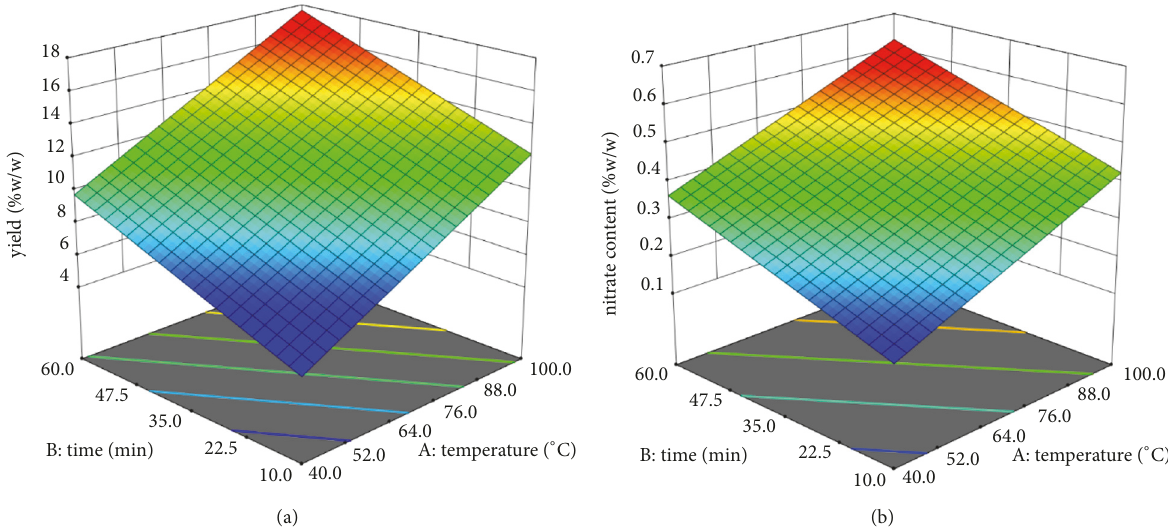
Figure 3: Response surfaces of model conditions of (a) yield of the extraction and (b) nitrate